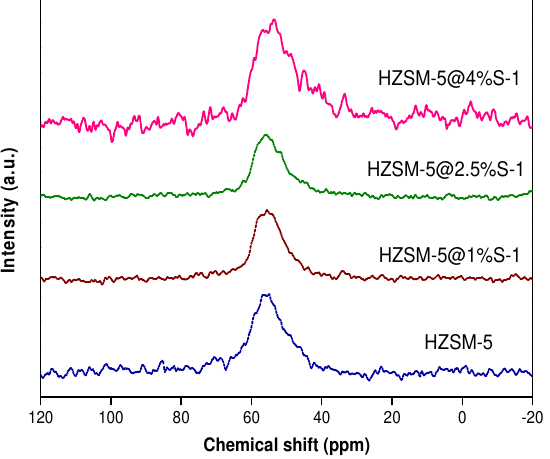
Figure 4. 27 Al MAS NMR spectrum of the as prepared parent HZSM-5 and HZSM-5@silicalite-1 samples.